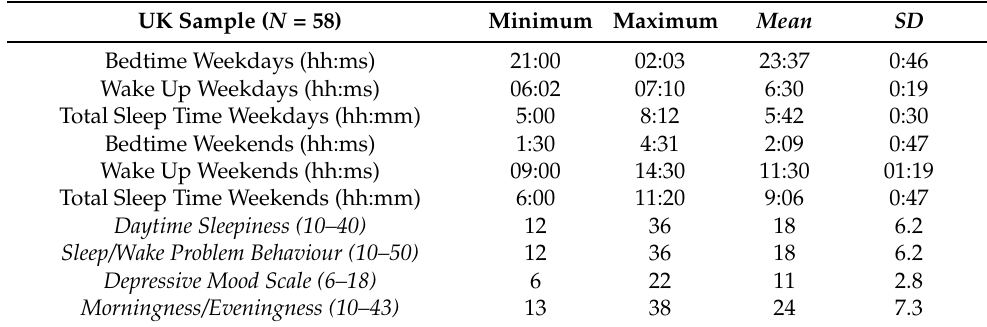
Table 1. Detailed summaries of the sleep patterns for TD adolescents in the UK, based on the scores derived from the School Sleep Habits Survey.